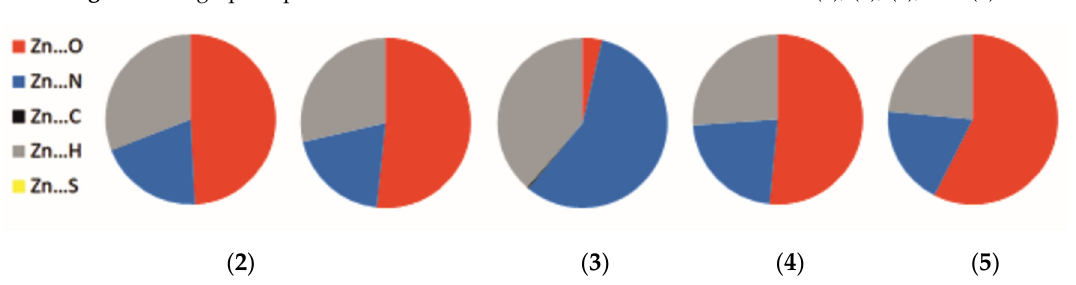
Figure 4. The percentage contribution of contacts of the Zn 2 + in complexes ( 2 ), ( 3 ), ( 4 ), and ( 5).